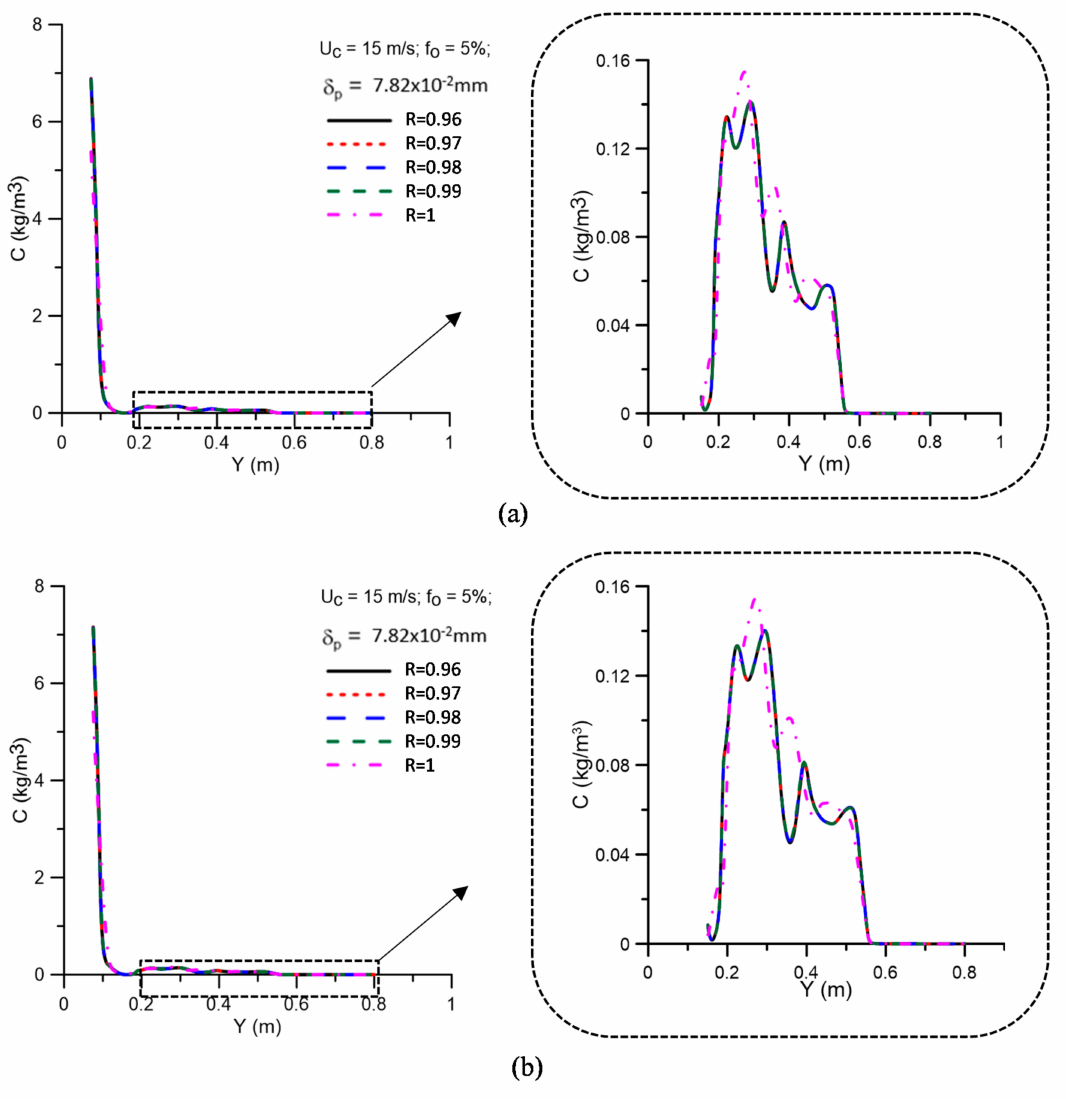
Figure 13. Oil concentration profiles as a function of the longitudinal position in the vicinity of the membrane for different values of the rejection coefficient, with ( a ) δ p = 0 mm and ( b ) δ p = 7.82 × 10 − 2